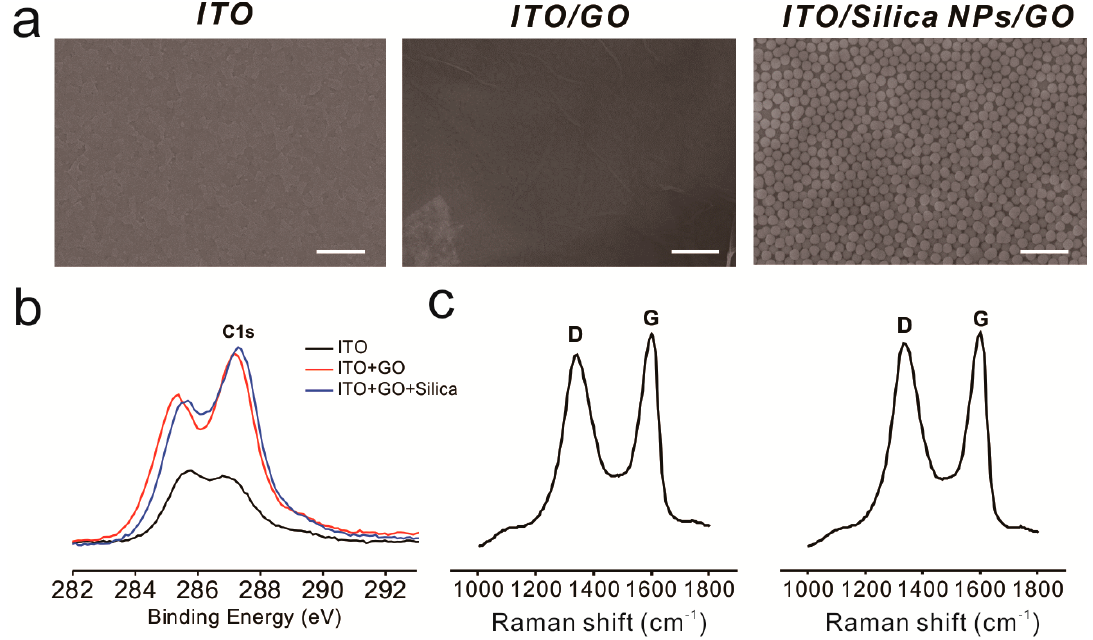
Figure 2. Characterization of the basic substrates. ( a ) Scanning electron microscopy images of indium tin oxide (ITO) (left), ITO/graphene oxide (GO) (middle), and ITO/GO/silica nanoparticles (SiNPs) (right). Scale bars = 1 μ m. ( b ) X-ray photoelectron spectroscopy (XPS) results for each substrate. ( c ) Raman spectroscopy data for ITO/GO (left) and ITO/GO/SiNPs (right).